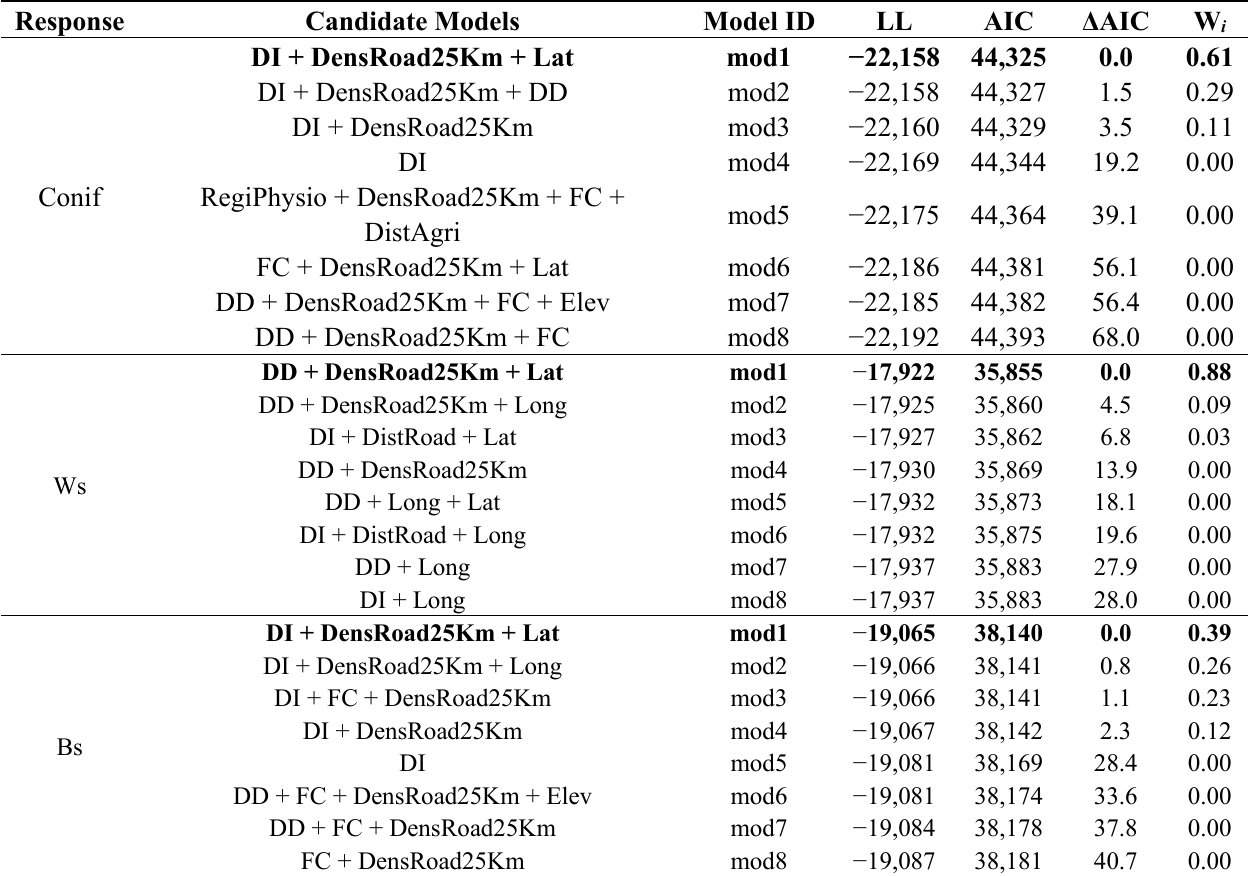
Table 3. Description and best models of abundance, based on Akaike’s information criterion